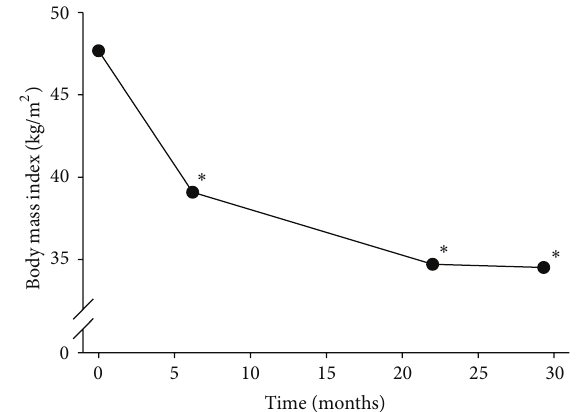
Figure 1: Change in body mass index (BMI) following formal conversion of VBG to RYGB. ∗ 𝑃 < 0.05 versus preoperative body mass